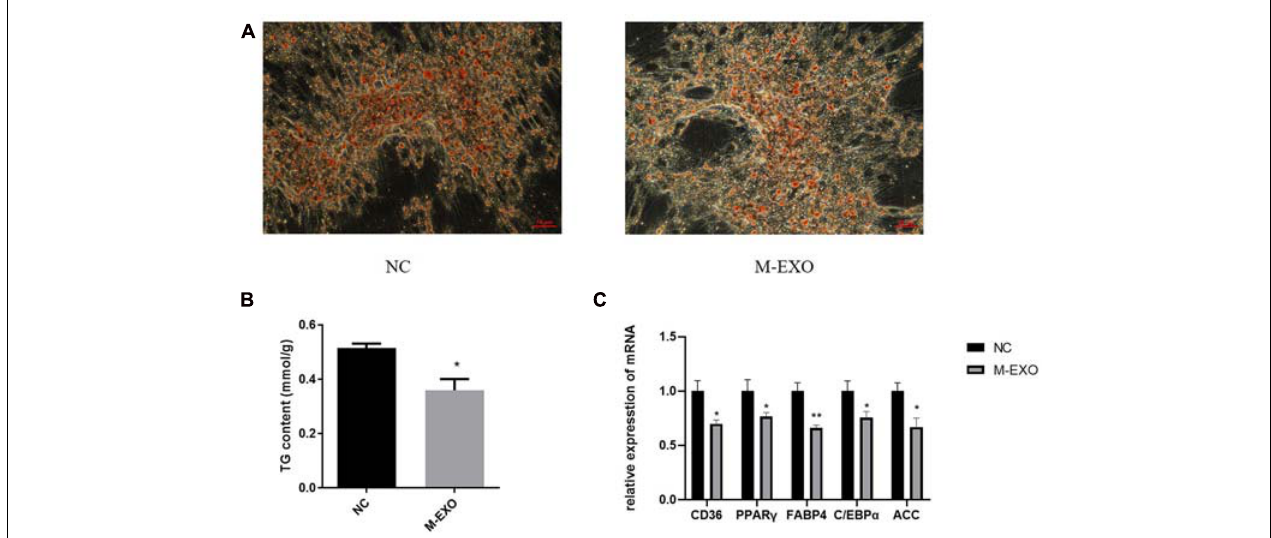
FIGURE 1 | Muscle derived exosomes inhibited adipogenesis in porcine preadipocytes. (A) Oil Red O staining at induction day 8. NC: Treated with PBS Exosome: Treated with muscle exosome. Scale bars, 50 µ m. (B) Triglyceride Assay was performed at induction day 8. TG level was adjusted by protein content. Each sample was assayed in duplicate ( n = 6), * P < 0.05; ** P < 0.01. (C) mRNA expression levels of CD36, PPAR γ , FABP4, C/EBP α , and ACC. NC: Treated with PBS Exosome: Treated with muscle exosome ( n = 6), * P < 0.05; ** P < 0.01.